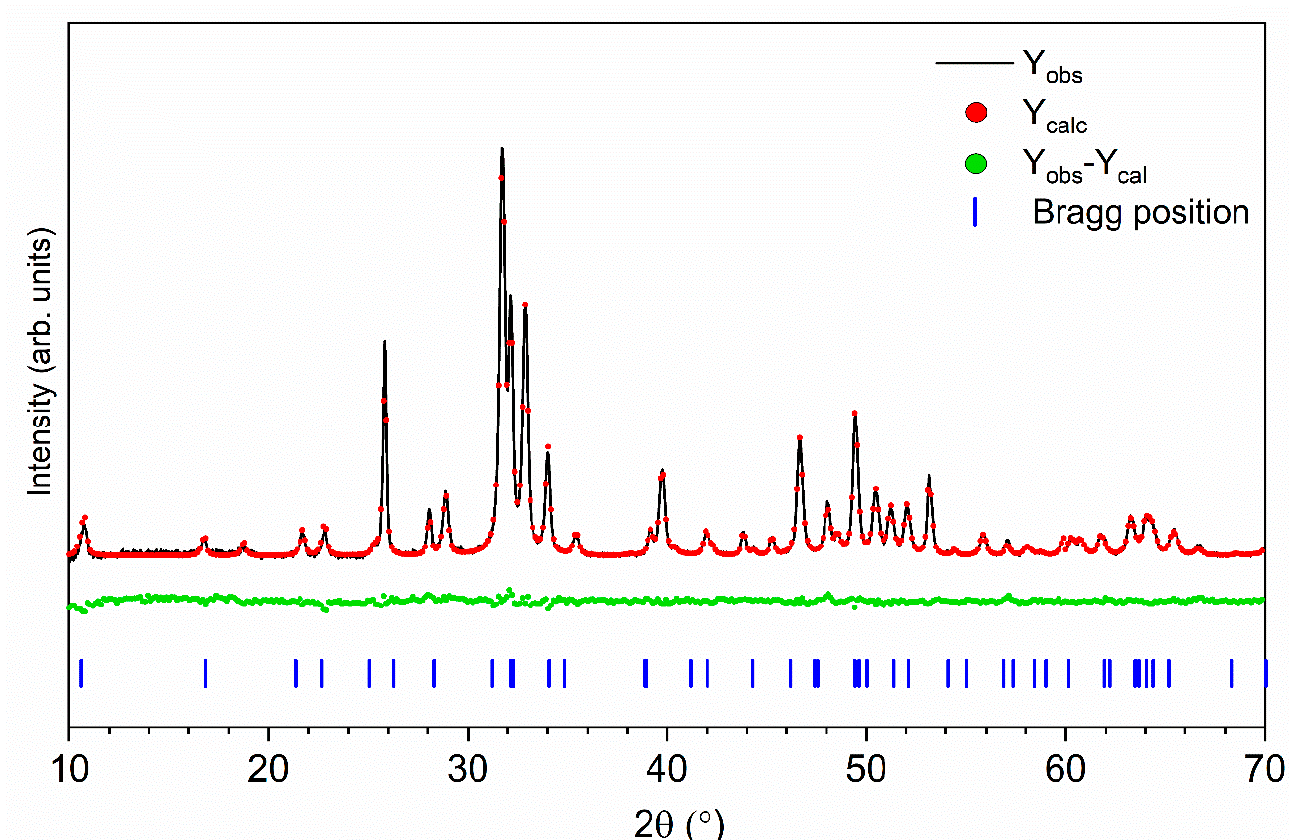
Figure 2. Representative results for the 0.5 mol% Eu 3+ /1 mol% Cu 2+ :Ca 10 (PO 4 ) 6 (OH) 2 :, Rietveld analysis (red—fitted diffraction, green—differential pattern, and blue column—reference phase peak position). Table 1. Unit cell parameters (a and c), cell volume (V), grain size, as well as refine factor (R W ) for the Eu 3+ -doped and